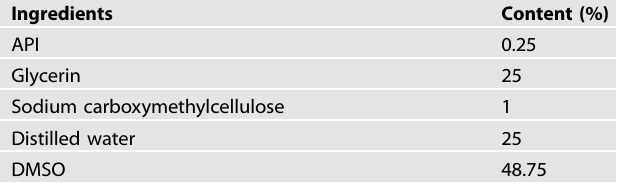
Table 2. The O/W cream base formulation of dexamethasone